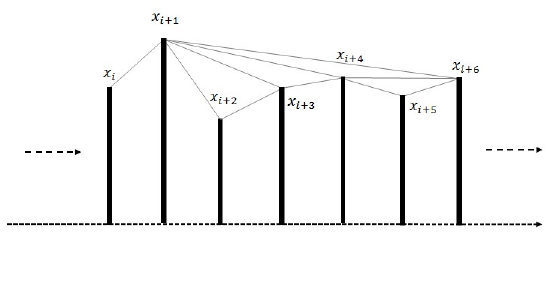
Figure 1. Visibility Graph for data series x i for i = 1,2,3, . .